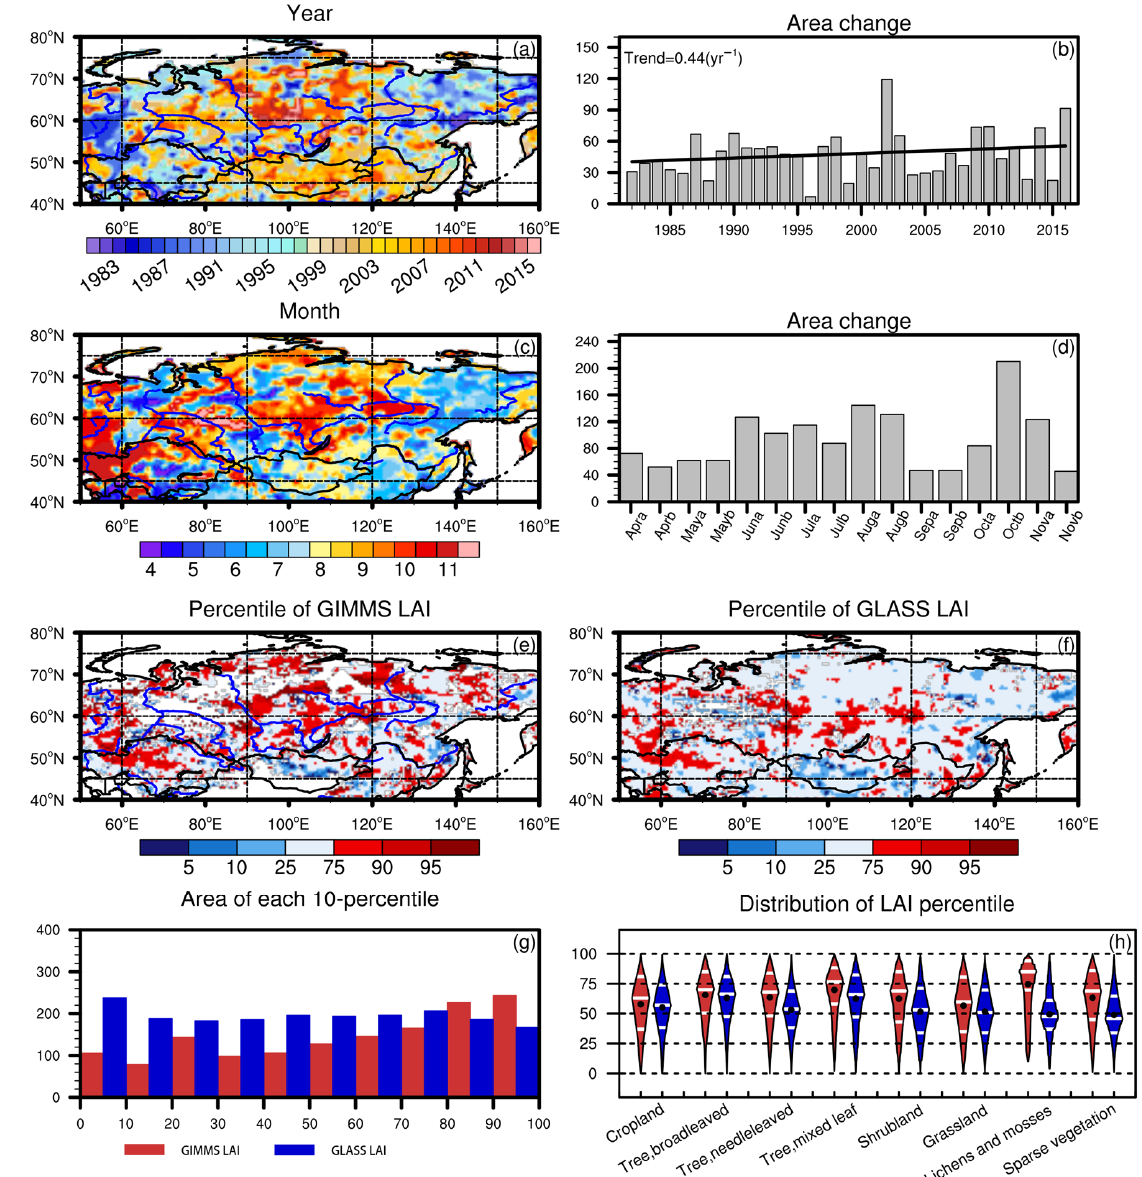
Figure 9. Same as Figure 5, but for the LAI when the minimum precipitation was recorded. Years ( a ), half-months ( c ), and percentiles of GIMMS LAI ( e ) and GLASS LAI ( f ) when the minimum precipitation was recorded, and the corresponding accumulated areas (unit in 104 km 2 . ( b , d , g ). The box plot ( h ) shows the percentile of the LAI for different vegetation types, with the white lines showing the 25th, 50th, and 75th percentiles, and the dots showing the averages. The line in b is the linear trend calculated by least-squares